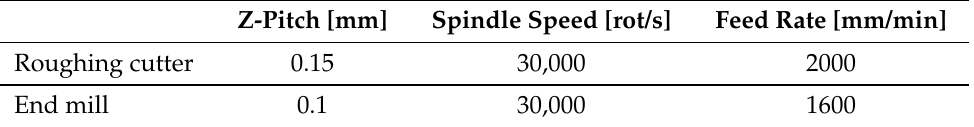
Figure 2. Two-stage milling process of hybrid manufacturing. Table 2. Milling process